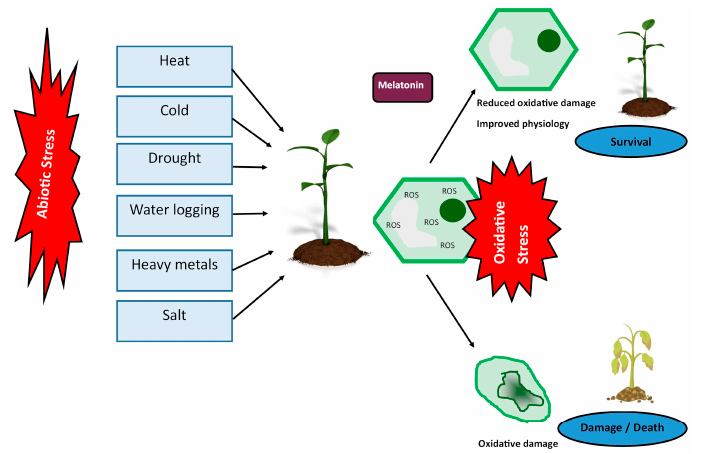
Figure 3. Role of melatonin in alleviating abiotic stress-induced oxidative damage in plants. Abiotic stress enhances the accumulation of ROS, which creates oxidative stress.